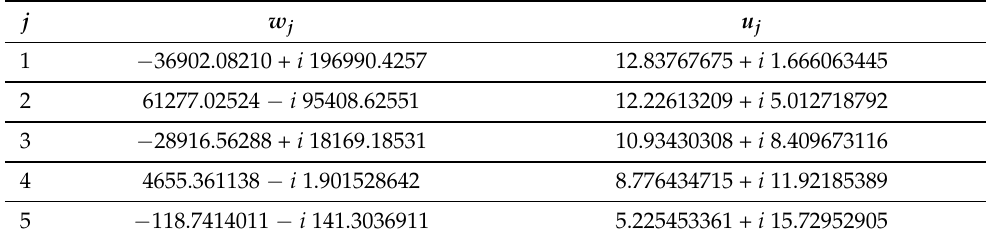
Table 1. Coefficients in the Zakian inversion